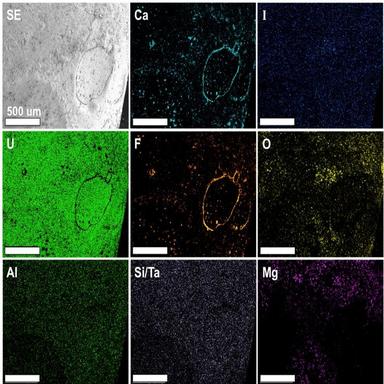
Large area image and elemental X-ray maps (10 kV) of a second region of the metal surface.